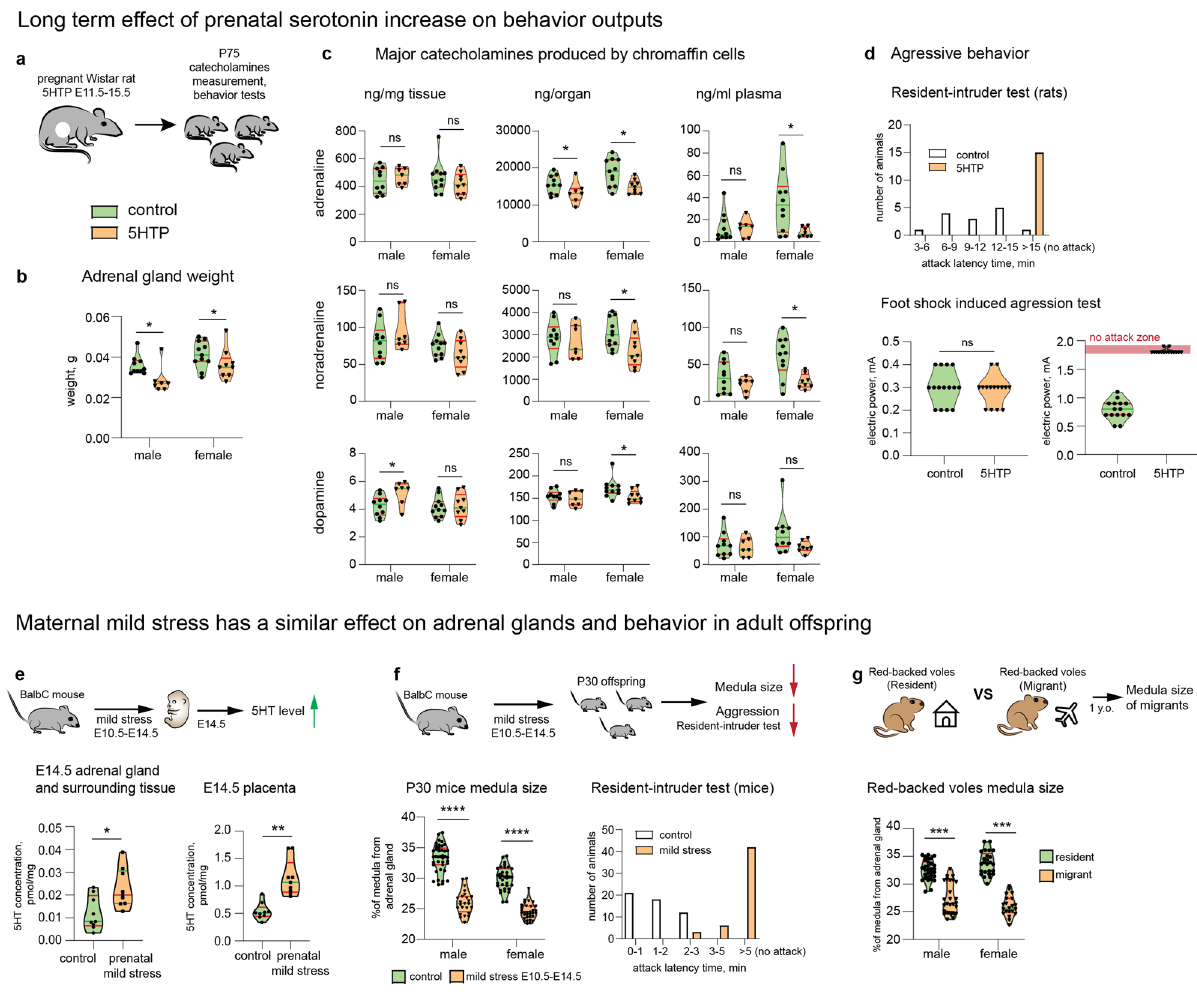
Fig. 7 Embryo-to-adult effects of prenatal 5HT on adult behavior and adrenals are similar to the effect of stress induced in pregnant mothers. a Pregnant Wistar rats were administered 5HTP during E11.5 – E15.5, and their offspring (P)75 was analyzed with the behavioral tests and catecholamine measurements. b The size of adrenal glands in animals from the 5HTP-treated females was signi fi cantly smaller then from control group. Mann – Whitney test, p -value * < 0.05, biological n = male: 11 (control), 8 (5HTP); female: 12 (control), 10 (5HTP). c Major catecholamines measured in ng/mg of tissue, ng/organ and ng/mL of plasma by HPLC-MS. Note: ng/mg of tissue re fl ects normal function of chromaf fi n cells, and does not change; ng/organ decreases in 5HTP-treated group. Mann – Whitney test, p -value ns > 0.05, * < 0.05, biological n = male: 11 (control), 8 (5HTP); female 12 (control), 10 (5HTP), for plasma n = male: 10 (control), 7 (5HTP); female 10 (female), 8 (female). d Aggression-assessing behavioral tests: “ resident-intruder test ” (top) and “ foot shock-induced aggression test ” (bottom) indicate the reduced aggression in the 5HTP-treated group. Mann – Whitney test, p -value ns > 0.05, biological n = 14 and 15 (control), 15 (5HTP group). e Pregnant BalbC mice were exposed to a mild stress (1 h restrain) at E10.5 – E14.5, followed by 5HT measurements in the embryo trunks and placentas. Note: the 5HT levels were increased similarly to experiment with 5HTP-treatment (refer to Fig. 2a, b). Mann – Whitney test, p -value * <0.05, ** < 0.002, biological n = 9. f Pregnant BalbC mice were exposed to a mild stress (1 h restrain) at E10.5 – E14.5, and their P30 offspring was tested for the size of adrenal medulla and aggression. Note: the proportion of adrenal medulla was signi fi cantly lower in the stress- induced group similarly to the 5HTP-treated group (refer to Fig. 2h). Shapiro – Wilk test for normality, unpaired double-sided t -test p -value, **** < 0.0001, n (adrenal gland) = 40 (control male), 24 (1 h restrain male), 35 (control female), 32 (1 h restrain female). g The ratio of adrenal medulla of the adrenal gland in C. rutilus . Mann – Whitney test, p -value * < 0.05, *** < 0.001, biological n (adrenal gland) = male: 31 (resident), 29 (migrant); female: 25 (resident), 21 (migrant). In all violon plots the green line — median, the red lines — quartiles. fertility status, approximate ages were determined visually after dissection. cycle of population dynamics of Micromammalia which is stable in the conditions Altogether 24 females and 31 males of ~1 year old were used for the study. of Yenisey Central Siberia. C.rutilus population dynamic peak occurred in Central Siberia in 2020 (mean 29,1 animals per 100 traps per day in 2020, compared to mean 13,8 animals per 100 traps per day in 2018. Year monitoring of ecological station “ Mirnoe ” ), and the collection period at the late summer\autumn considered 5HTP administration to pregnant females and embryo collection . Three- to the most relevant to estimate the wave dynamics in cycling population 55 . four-month-old females of Wistar rats, BalbC mice, and 2 – 4-month-old Htr3a EGFP Representatives of C. rutilus collected in Sherman traps (live traps) in taiga (dark mice were placed in time-controlled mating and the day of plug was considered as coniferous forest consisting of Siberian cedar, fi r, pine, and larch) were considered embryonic day (E) 0.5 for mice, day of conception was considered as embryonic as settled individuals or residents. Representatives collected in pitfall traps in day (E) 0.5 for rats. 5-hydroxy-L-tryptophan (Sigma-Aldrich H9772) was dissolved Yenisey River valley (meadows without tree communities) were considered as in saline and fed (1mg/kg BW, once a day) to pregnant rats through gavage or migrants. Trapped species were settled individually in plastic boxes for 2 h. The intraperitoneally injected (40 mg/kg BW, once a day) to pregnant mice females. At animals were weighed and adrenals were dissected under inhalant iso fl urane the stage of embryo harvest, the females were sacri fi ced by cervical dislocation after anesthesia (SomnoSiute system, Kent Scienti fi c, USA). The gender, pregnancy and NATURE COMMUNICATIONS| (2022) 13:2901